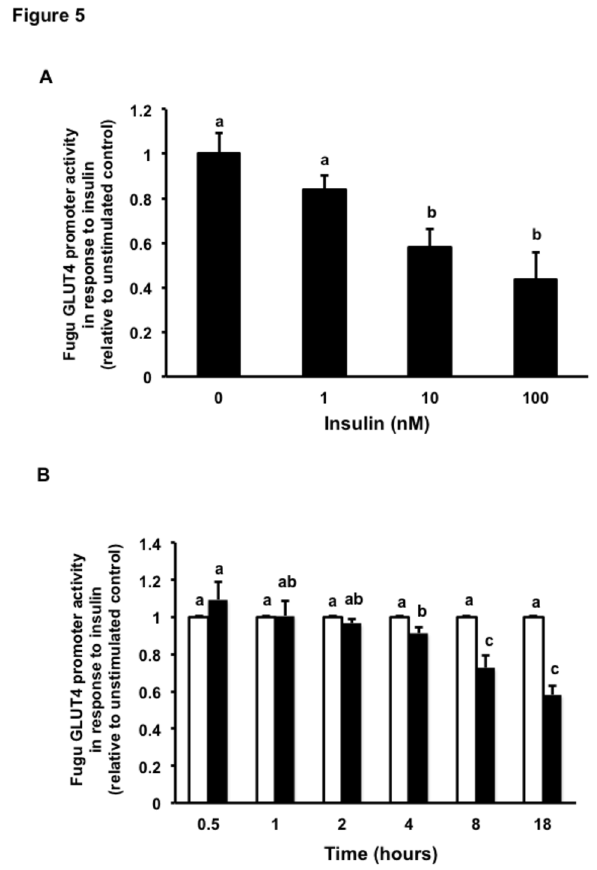
Figure 5. Dose- and time-dependent regulation of the activity of the Fugu GLUT4 promoter in response to insulin. (A) Dose-response effects of insulin. Transfected L6 muscle cells were incubated in the absence (unstimulated control) or presence of various concentrations of human recombinant insulin (1, 10 and 100 nM). Data are normalized to the relative expression of Renilla luciferase activity, setting the activity of the unstimulated promoter to 1. Data on Fugu GLUT4 promoter activity in response to insulin are shown relative to that of the unstimulated control and expressed as mean ± S.E. of four independent experiments. (B) Time- dependent effects of insulin. Transfected L6 muscle cells were incubated in the absence (unstimulated control; white bars) or presence of human recombinant insulin (100 nM; black bars) for for 0.5, 1, 2, 4, 8 and 18 hr. Data are normalized to the relative expression of Renilla luciferase activity, setting the activity of the unstimulated constructs to 1. Data on Fugu GLUT4 promoter activity in response to insulin are shown relative to that of the unstimulated control and expressed as mean ± S.E. of four independent experiments. Promoter activities of the unstimulated FuguGLUT4P-1132 construct at 0.5, 1, 2, 4, 8, 18 hrs were 22.82 ± 5.1; 34.27 ± 8.1; 26.31 ±